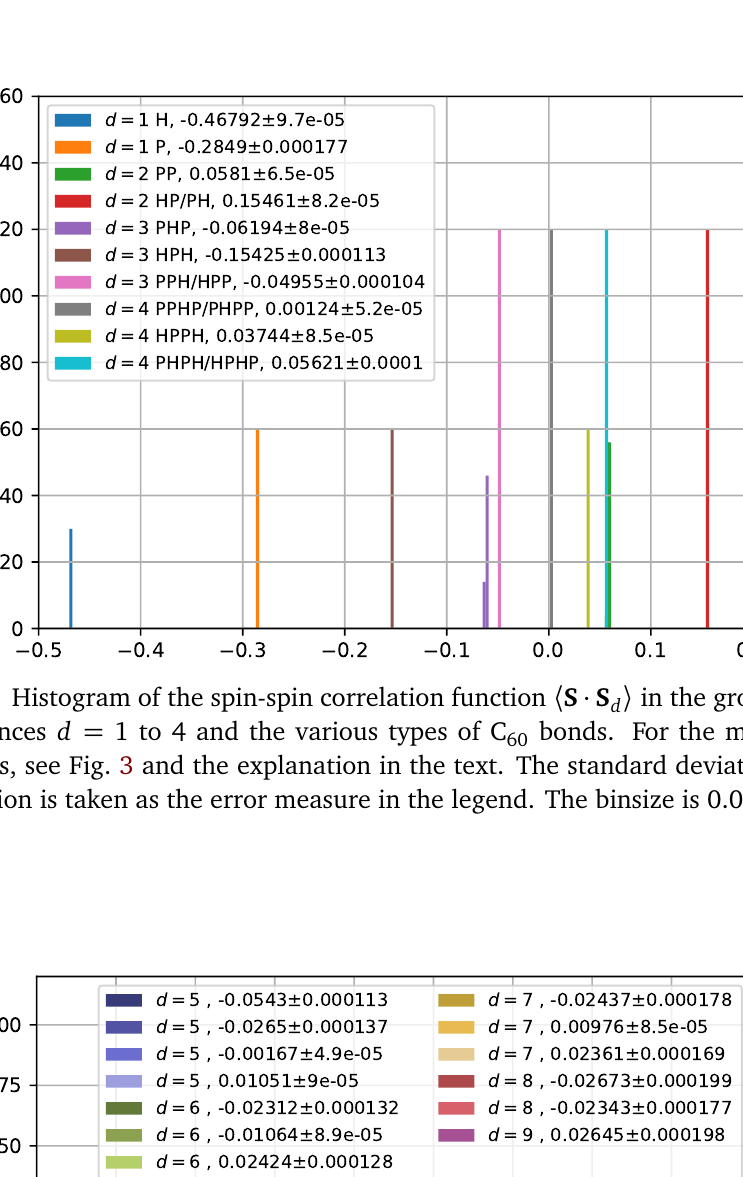
Figure 2: Histogram of the spin-spin correlation function 〈 S · S for distances d = 5 to 9 and the various types of C of the distribution is taken as the error measure in the legend. The binsize is